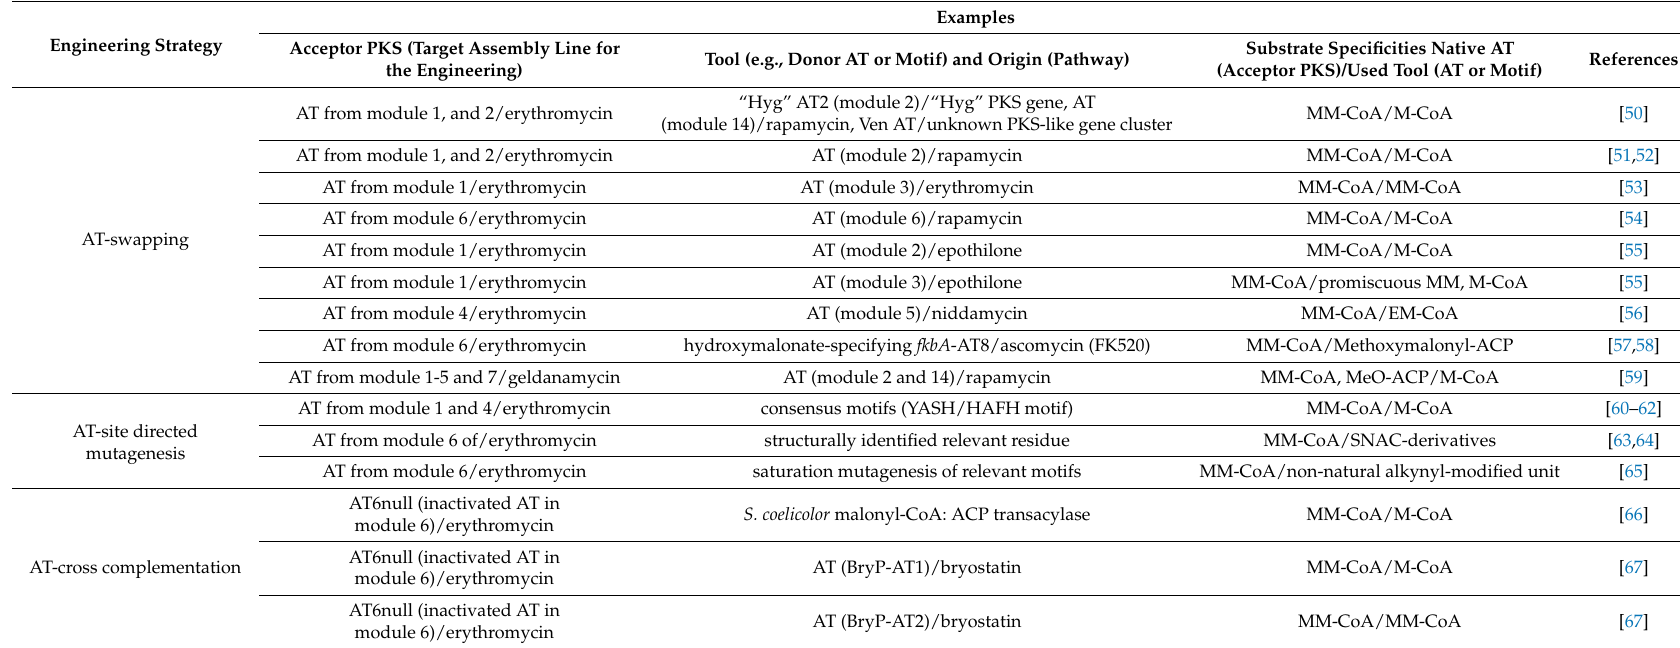
Table 1. Examples of acyltransferase-based polyketide synthase engineering. Abbreviations: acyltransferase (AT); methylmalonyl-coenzyme A